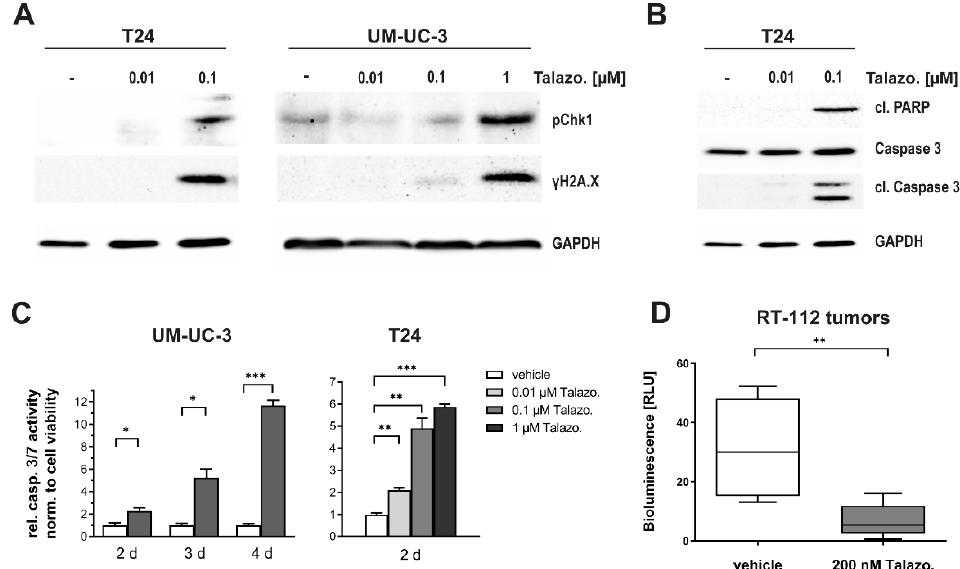
Figure 3. Talazoparib induces both DNA damage and apoptosis and is highly effective in suppressing BLCA tumor growth. ( A ) Protein markers for DNA damage response quantified by Western blot analysis 96 h after treatment. ( B ) Western blot analysis for the quantification of protein markers for apoptosis 96 h after treatment. ( C ) Dependency of Caspase 3/7 activity on the period (UM-UC-3) or the dosage (T24) of Talazoparib treatment. Data are presented as mean ± SD of biological triplicates. ( D ) In vivo effectivity of Talazoparib monotherapy against three-dimensionally grown RT-112 cells by chicken chorioallantoic membrane (CAM) assay. Data are representative of at least three independent experiments. Box and whisker plot depicting the minimum, median, and maximum samples of n = 8 for the vehicle and n = 14 for Talazoparib-treated tumors. Statistical comparison was performed using t -test of GraphPad Prism V9 software, indicating respective p -values: *: p ≤ 0.05, **: p ≤ 0.01, and ***: p ≤ 0.001.